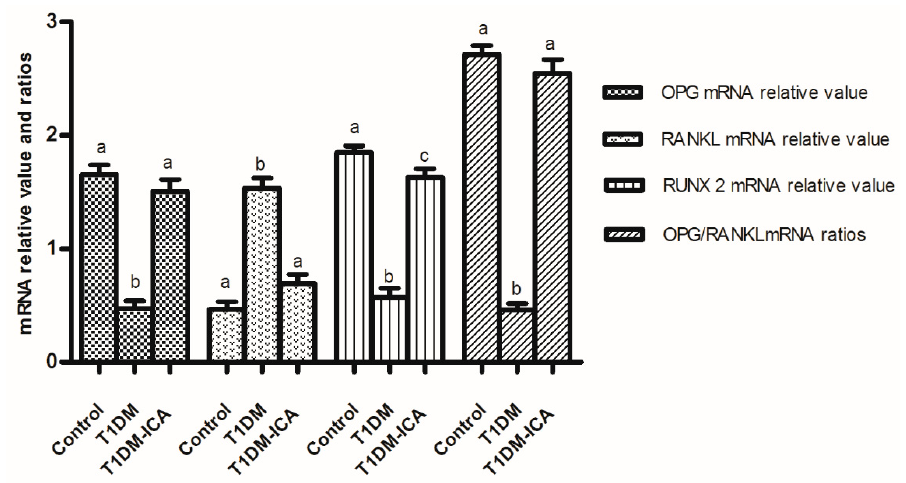
Figure 7. The expression of OPG, RANKL and RUNX 2 mRNA, and OPG/RANKL mRNA ratio in bone tissues of all experimental groups. Values are presented as means ± SD. Different letters (a, b, c) indicate statistically significant difference ( p < 0.05).